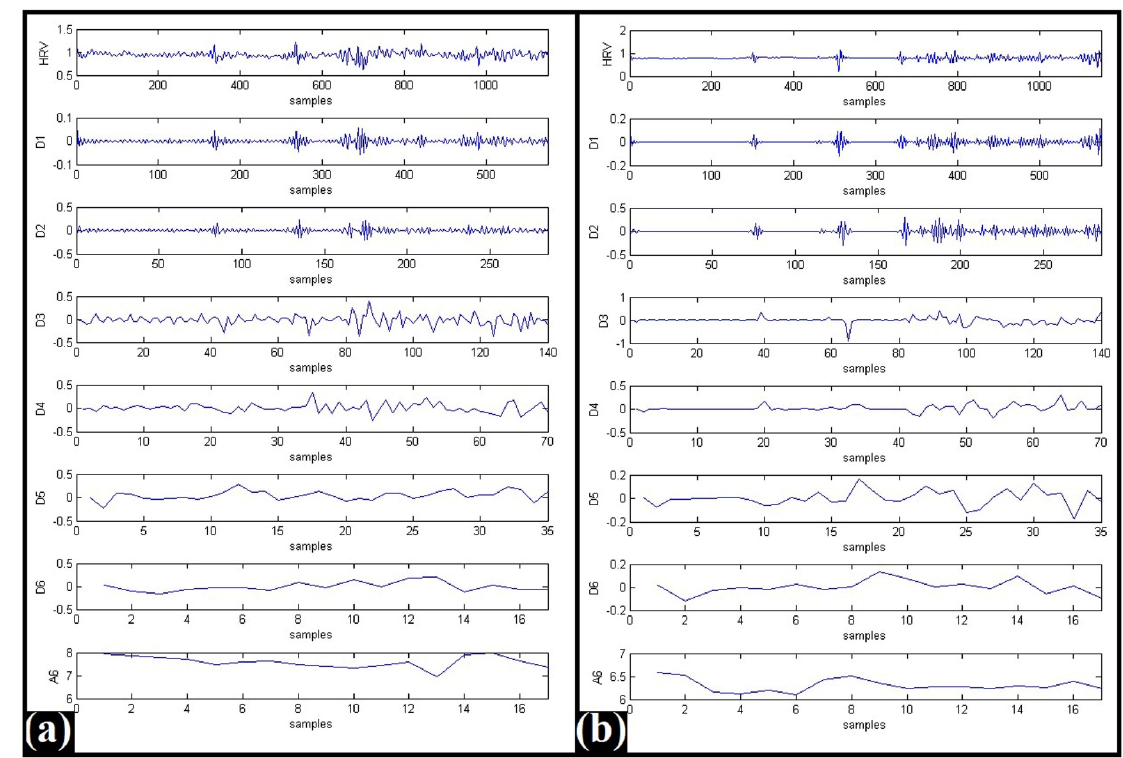
Figure 3. Typical DWT coefficients for db02 mother wavelet-based level 6 decomposition of HRV signals: ( a ) Category-C and ( b ) Category-B. A total of 11 entropy-based parameters were extracted from each wavelet coefficient. Table 3. Characteristics of statistically important parameters extracted from db02 mother wavelet- based level 2 decomposition of the HRV signals using